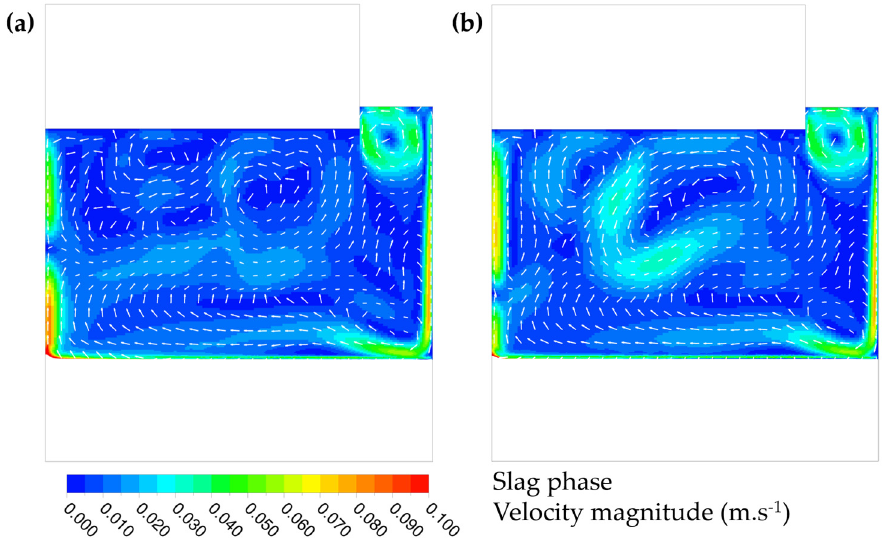
Figure 6. Slag phase velocity magnitude and normalized slag velocity vectors (time-averaged) for the case without drops ( a ) and considering the drops fall ( b ).